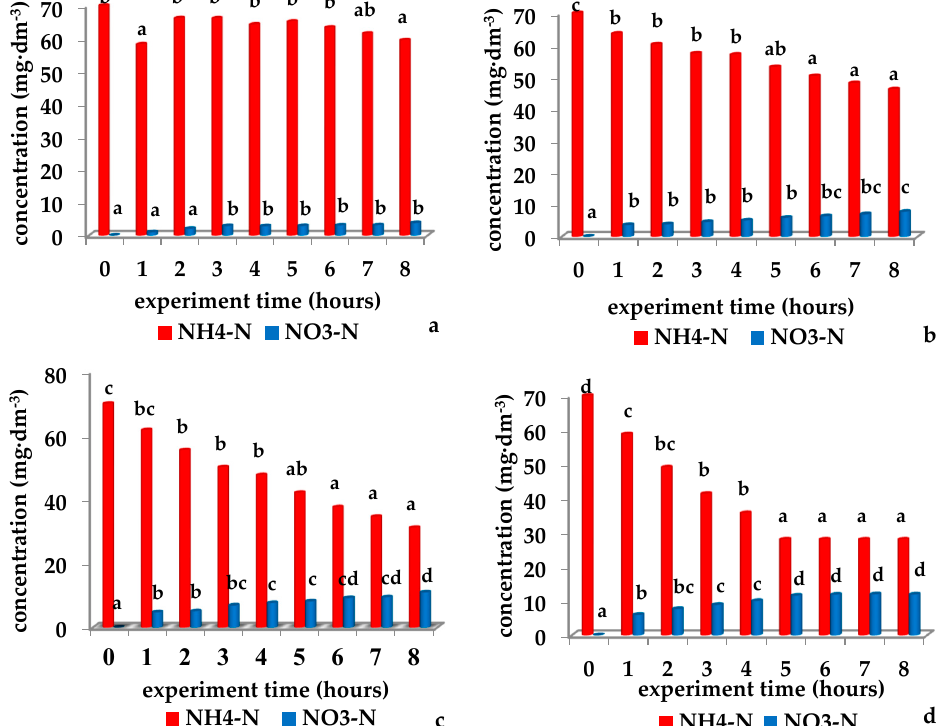
Figure 5. Influence of the ( a ) 24 ‐ h, ( b ) 48 ‐ h, ( c ) 72 ‐ h, ( d ) 96 ‐ h time of settling of activated sludge by nitrifying bacteria on the increase in the efficiency of the nitrification process—dynamic conditions; * averages marked with the same letters are not significantly different by Tukey test ( α = 0.05) (one ‐ way ANOVA, separately for concentration of NH 4 ‐ N and NO 3 ‐ N).